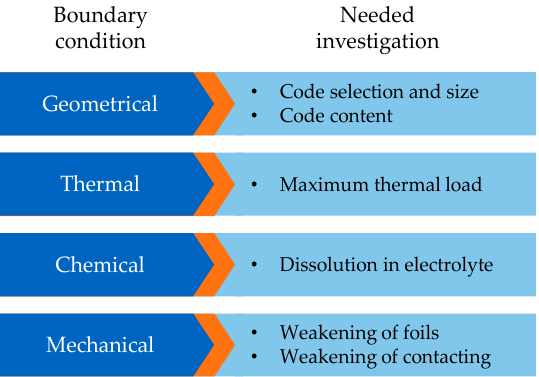
Figure 1. Appropriate investigations are derived from the geometric, thermal, chemical, and me- chanical boundary conditions of battery cell production.